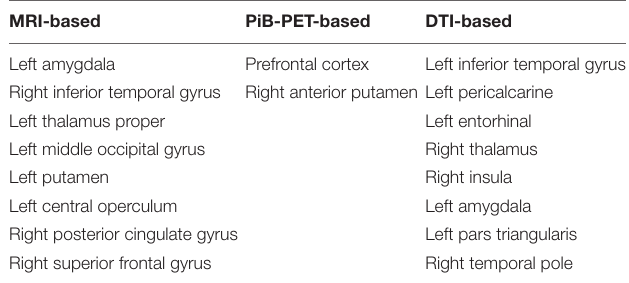
TABLE 3 | Summary of the feature selection methods for the selected models. Model